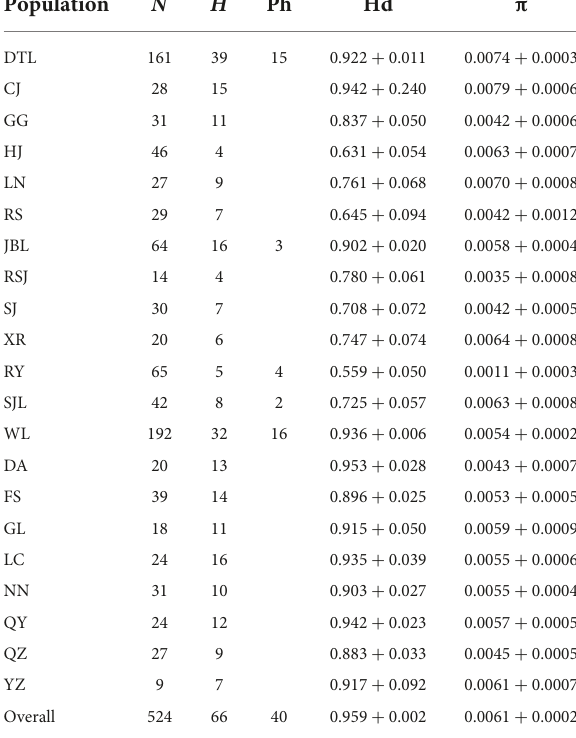
TABLE 1 Estimates of genetic diversity for the 18 populations of